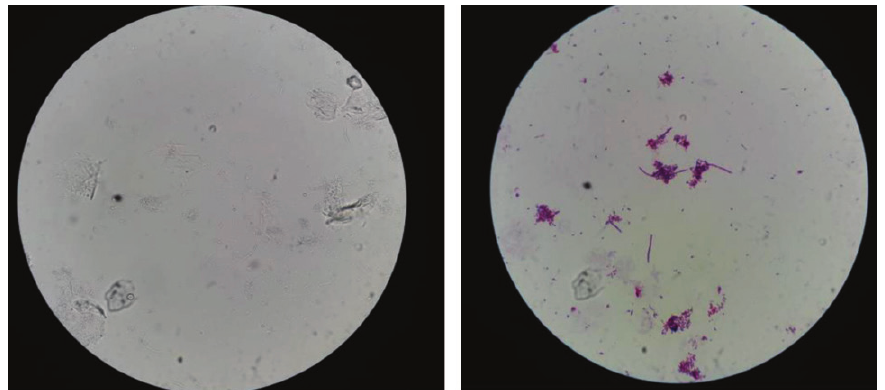
Fig. 2. The results of KOH and Gram examinations showed blastopores and